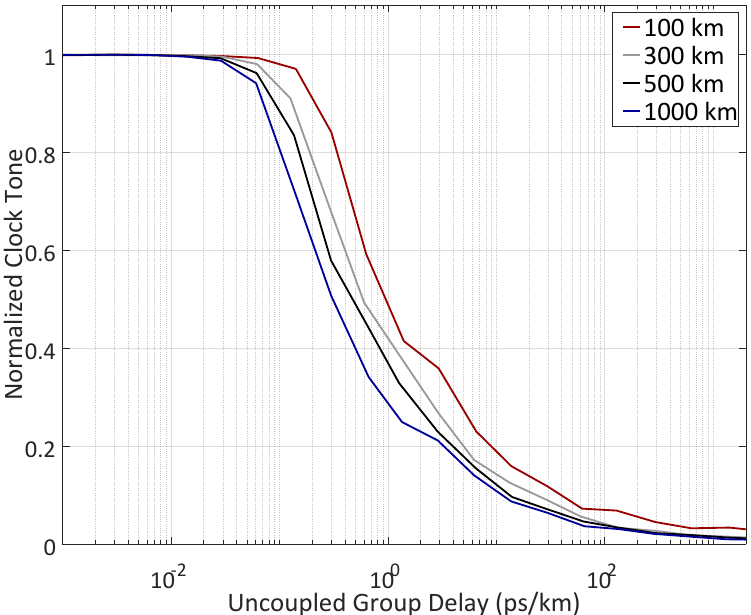
Figure 9. Normalized clock tone amplitude as a function of uncoupled group delay between mode groups in a 3-mode FMF for distinct transmission